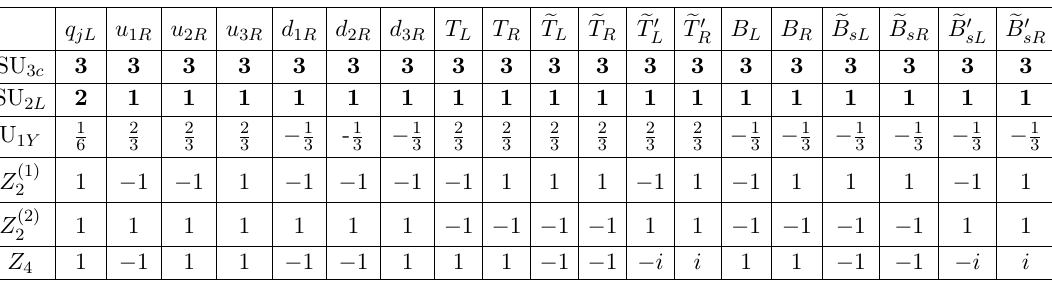
× Z (2) × Z 4 . Here j = 1 , 2 , 3 and 2 2